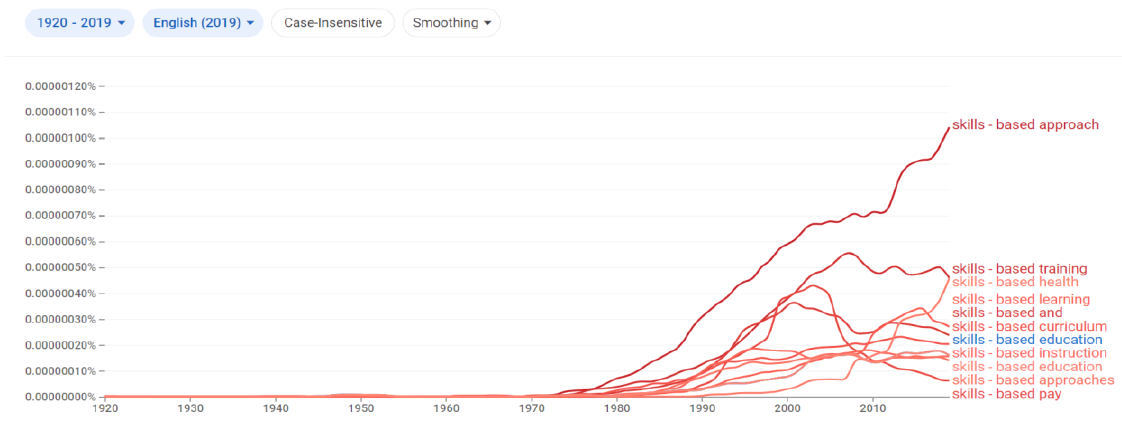
F IGURE 3. T HE OCCURRENCE OF THE “ SKILLS - BASED ” PHRASES IN A CORPUS OF E NGLISH